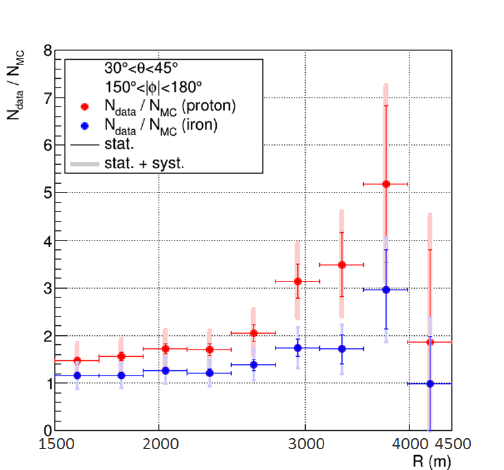
Figure 11. Data / MC ratio of signal size as a function of R for proton (red circles) and iron (blue circles) primaries. (Figure from [6])